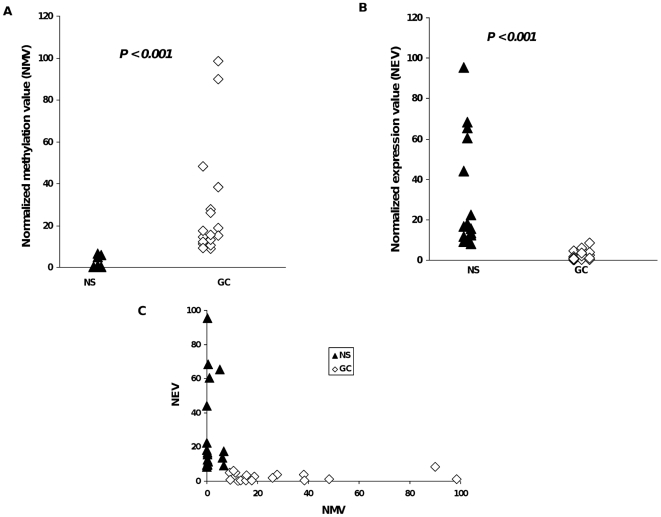
Promoter methylation and mRNA expression levels of claudin-11 (CLDN11) in clinical specimens.This figure illustrates the promoter methylation and mRNA expression levels of CLDN11 in paired gastric cancer (GC) and noncancerous gastric mucosal (NS) tissues. A) Quantitative methylation-specific PCR (qMSP) for CLDN11 in primary tissues. Genomic DNA extracted from 18 GC and 18 matched NS tissues were subjected to qMSP analysis using MSP amplicon and TaqMan probe designed to include multiple CpG sites in the 5′-UTR region of CLDN11 gene. CpGenome Universal Methylated DNA (Chemicon International, Temecula, CA) was used as a fully methylated positive control. Duplex PCR with β-actin (ACTB) primer and probe sequences containing no CpGs were performed for normalization. Normalized methylation value (NMV) was defined as follows: NMV = (CLDN11-S/CLDN11-FM)/(ACTB-S/ACTB-FM) * 100, where CLDN11-S and CLDN11-FM represent CLDN11 methylation levels in the sample and fully methylated DNAs, respectively, while ACTB-S and ACTB-FM correspond to β-actin in the sample and fully methylated DNAs, respectively. This one-dimensional scatterplot demonstrates significantly high CLDN11 promoter methylation levels in the GC specimens when compared to the NS specimens (P<0.001). Whole-genome amplified DNA (WGA) used as an unmethylated negative control did not show any amplification. The P value was calculated using the paired Student's t-test. B) CLDN11 mRNA expression in gastric tissues. Total RNA extracted from 18 paired NS and GC specimens were subjected to CLDN11 specific RT-PCR. CLDN11 mRNA expression was normalized to β -actin mRNA expression in each sample. The P value was calculated using the paired Student's t-test. This plot demonstrates that the CLDN11 mRNA expression levels were significantly lower to non-detectable in the GC specimens, while most of the corresponding NS specimens had detectable CLDN11 mRNA levels (P<0.001). C) 2D-scatter plot of promoter methylation and mRNA expression values in GC tissues. CLDN11 mRNA expression silencing is associated with promoter hypermethylation in GC patients. This two-dimensional scatterplot demonstrates NEV values (Y-axis) and NMV values (X-axis) in the 18 paired NS and GC specimens.